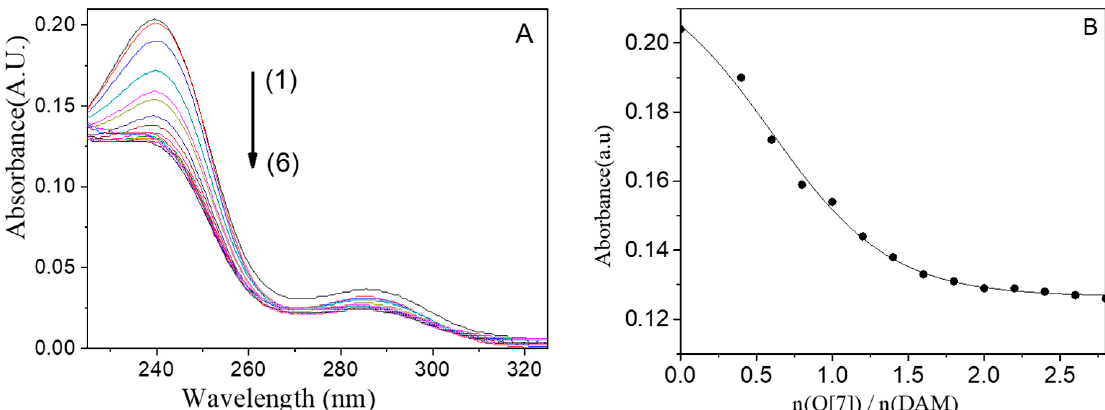
Figure 7. ( A ) The UV-vis spectrometry of the solution of MDA with adding Q[7] at different concen- trations. ( B ) The maximum absorption peak corresponding to the ratio of N (Q[7]) /N (MDA) .